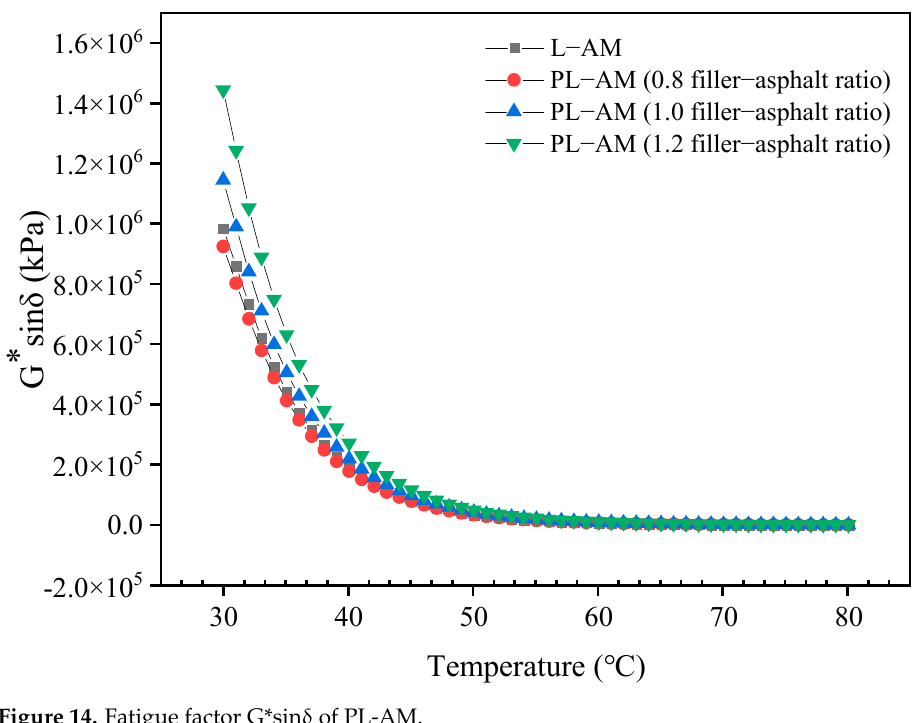
Figure 14. Fatigue factor G*sin δ of PL-AM.